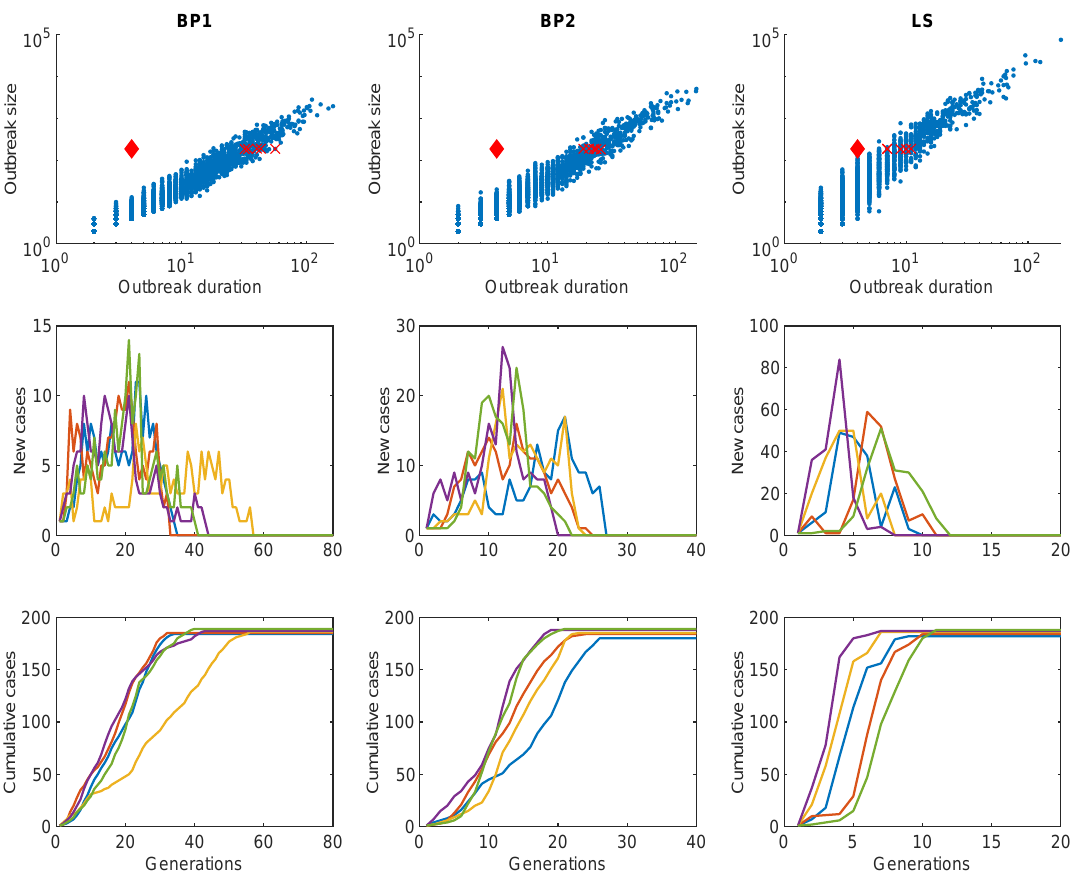
Figure 6. Scatter plot for the results of 5000 simulations on three models (upper panels); the red diamond mark indicates the cases of the 2015 MERS-CoV outbreak (fourth generation; outbreak size, 186 cases). The middle panels show the results of five incidence cases that are the nearest cases to the 2015 MERS-CoV outbreak according to each model (red cross marks in each scatter plot) and the bottom panels show the cumulative cases of the five incidence cases. Table 3. Simulation results for the three models ( R 0 = 0.96 and k = 0.063 ) are compared with the MERS-CoV data.